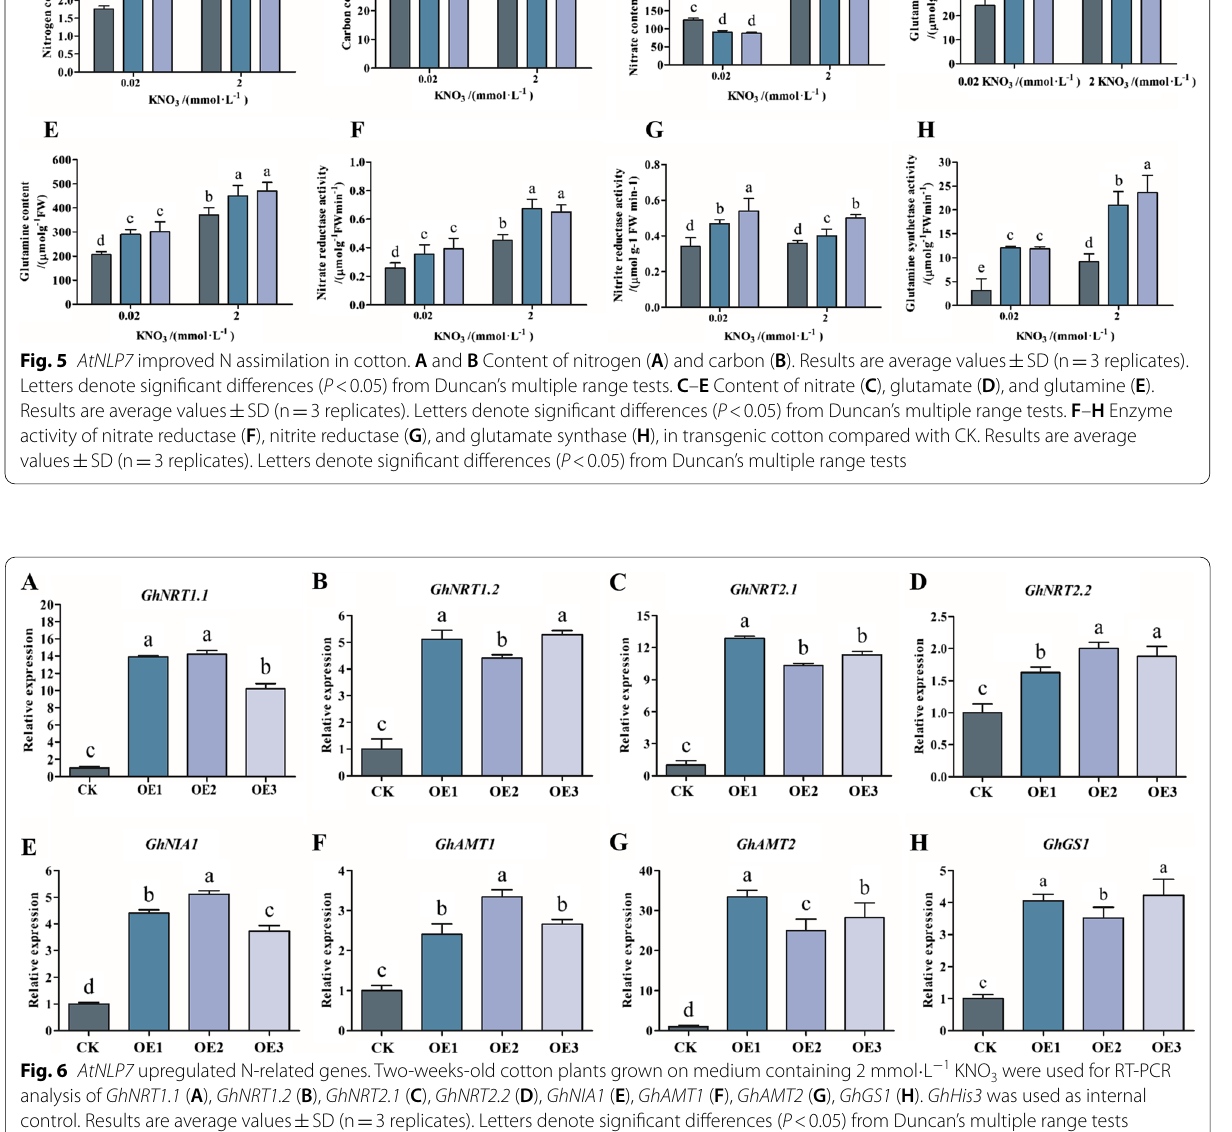
L − 1 KNO 3 were used for RT-PCR ·